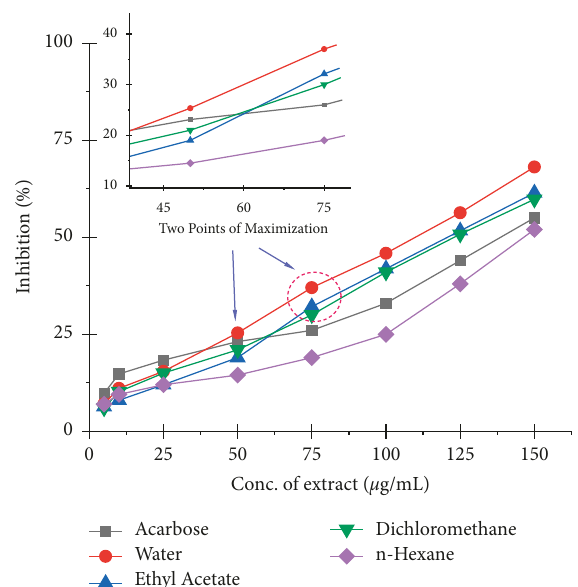
Figure 2: α -Glucosidase median inhibitory potential of Veronica biloba extracts.